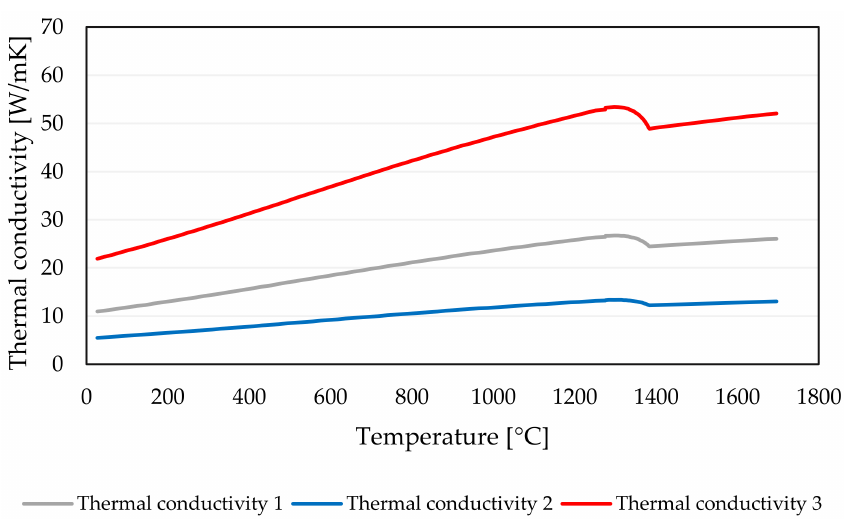
Figure 4. Thermal conductivity as a function of temperature